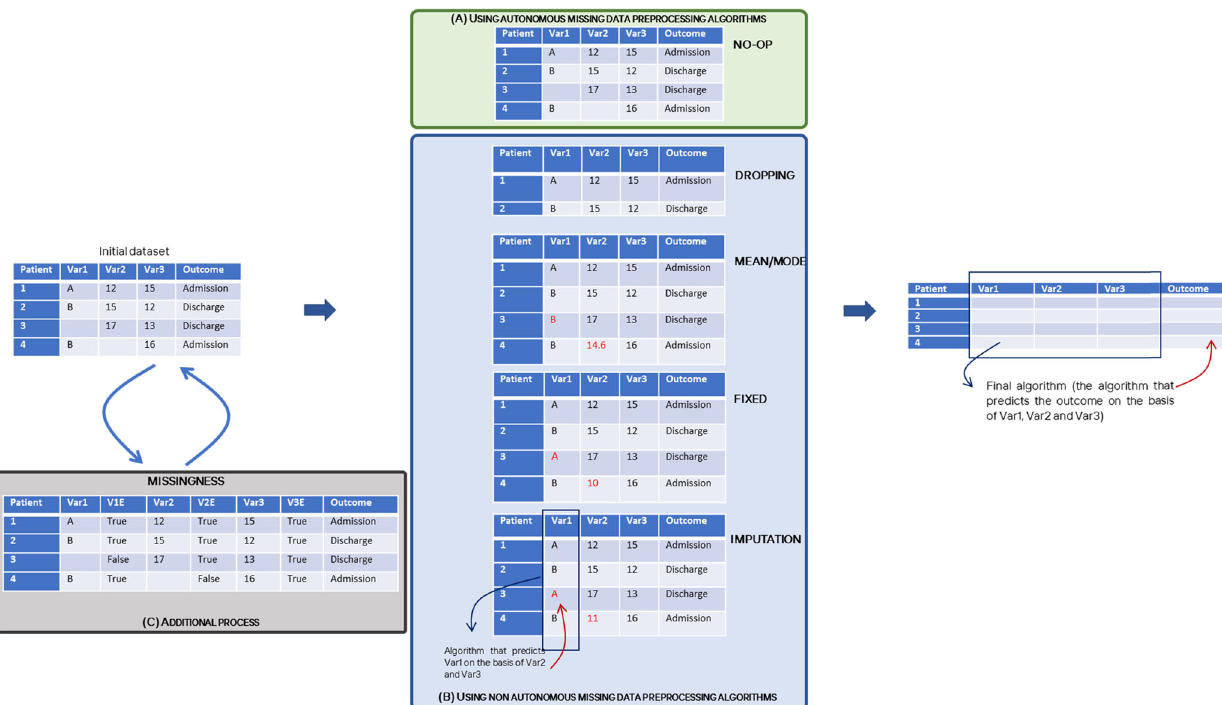
Fig. 1 Missing data strategies applied before the fi nal (predictive) algorithm. A Missing data strategy using autonomous missing data preprocessing algorithms. B Missing data strategies using non autonomous preprocessing algorithm. C Missing data strategies using additional